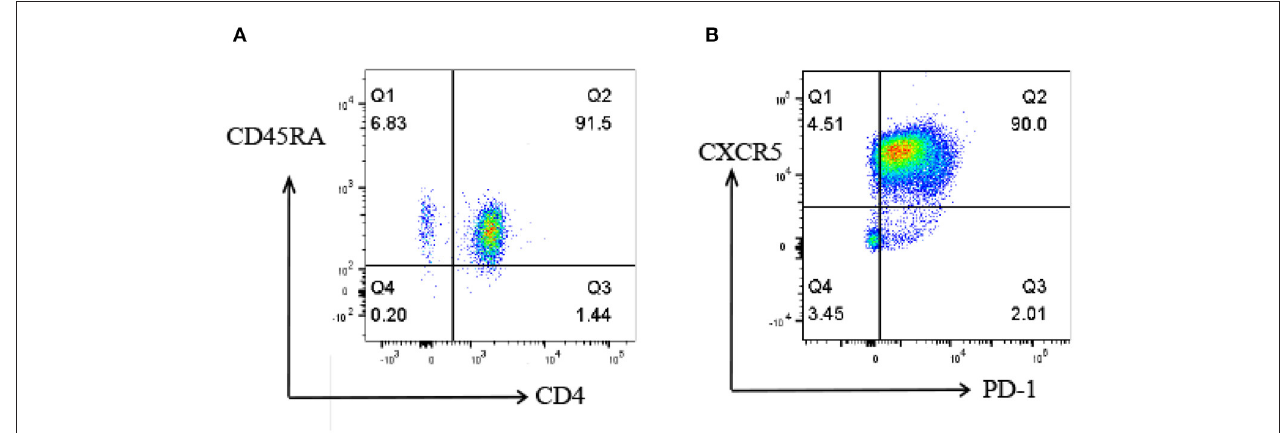
FIGURE 2 | Flow cytometry analysis of naive CD4 + T cells and iTfh cells. (A) the percentage of isolated CD4 + CD45RA + T cells is 91.5%. (B) the percentage of CXCR5 + PD-1 + CD4 + T cells is up to 90% on day 5 of in vitro Tfh differentiation.